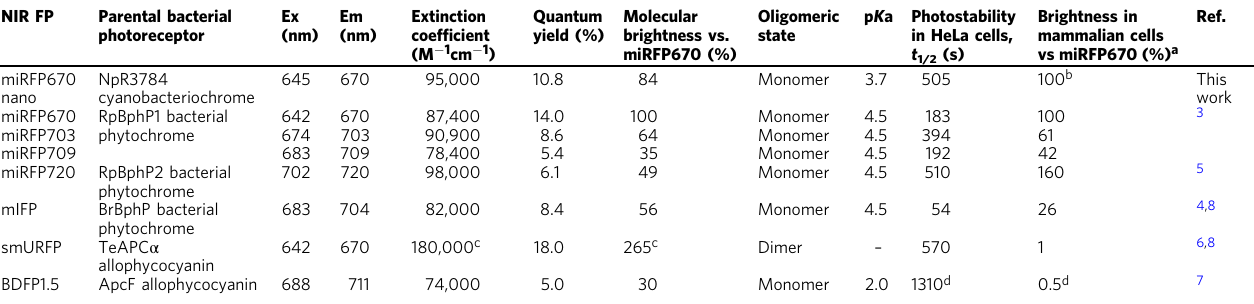
Table 1 Properties of currently available monomeric NIR FPs designed from various bacterial photoreceptors NIR FP Parental bacterial